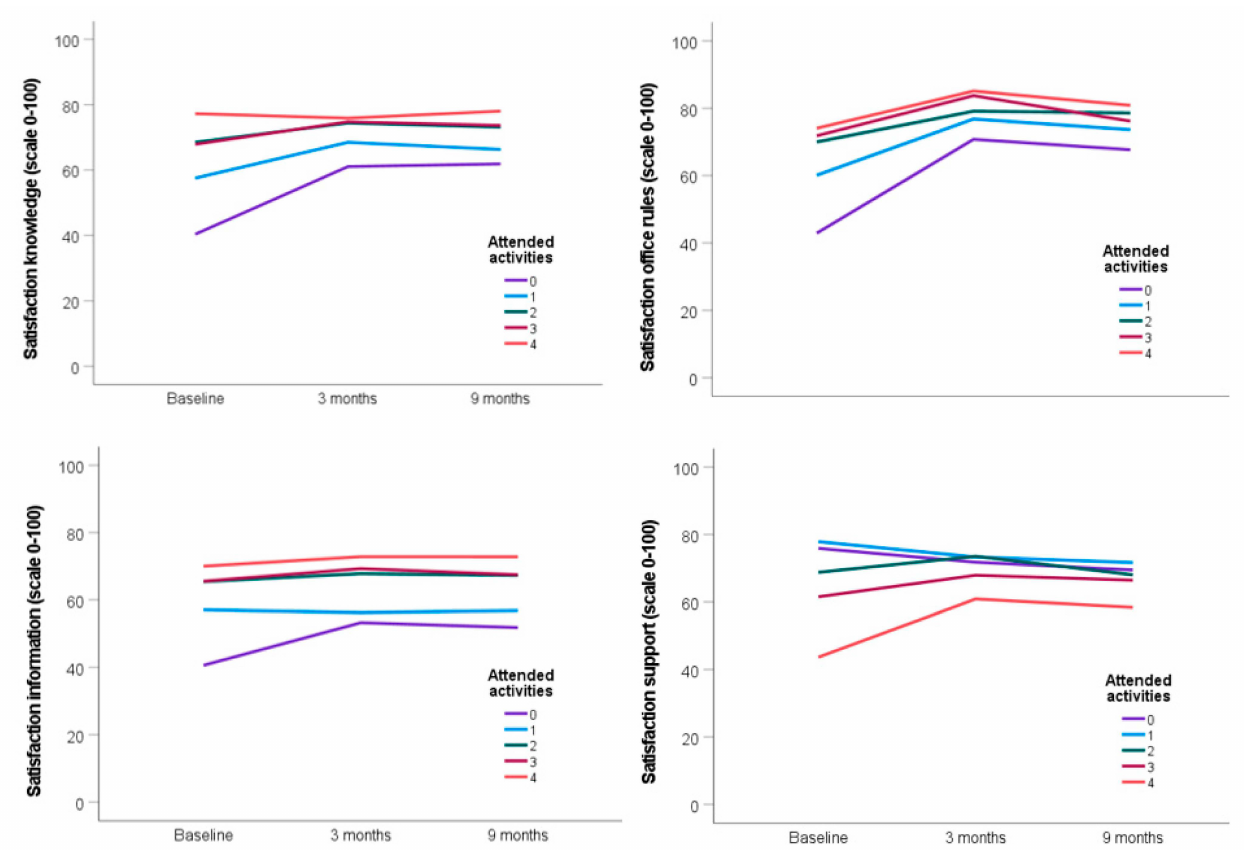
Figure 2. The figures show the change in rated satisfaction with knowledge about ABW, office rules, information and support at baseline, 3 and 9 months after relocation when participating in 1–4 activities, compared to the change in the non-participation